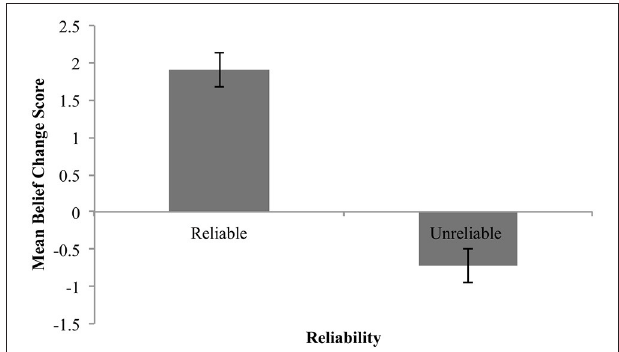
FIGURE 2 | Mean belief change for reliable and unreliable sources. Error bars are standard error.